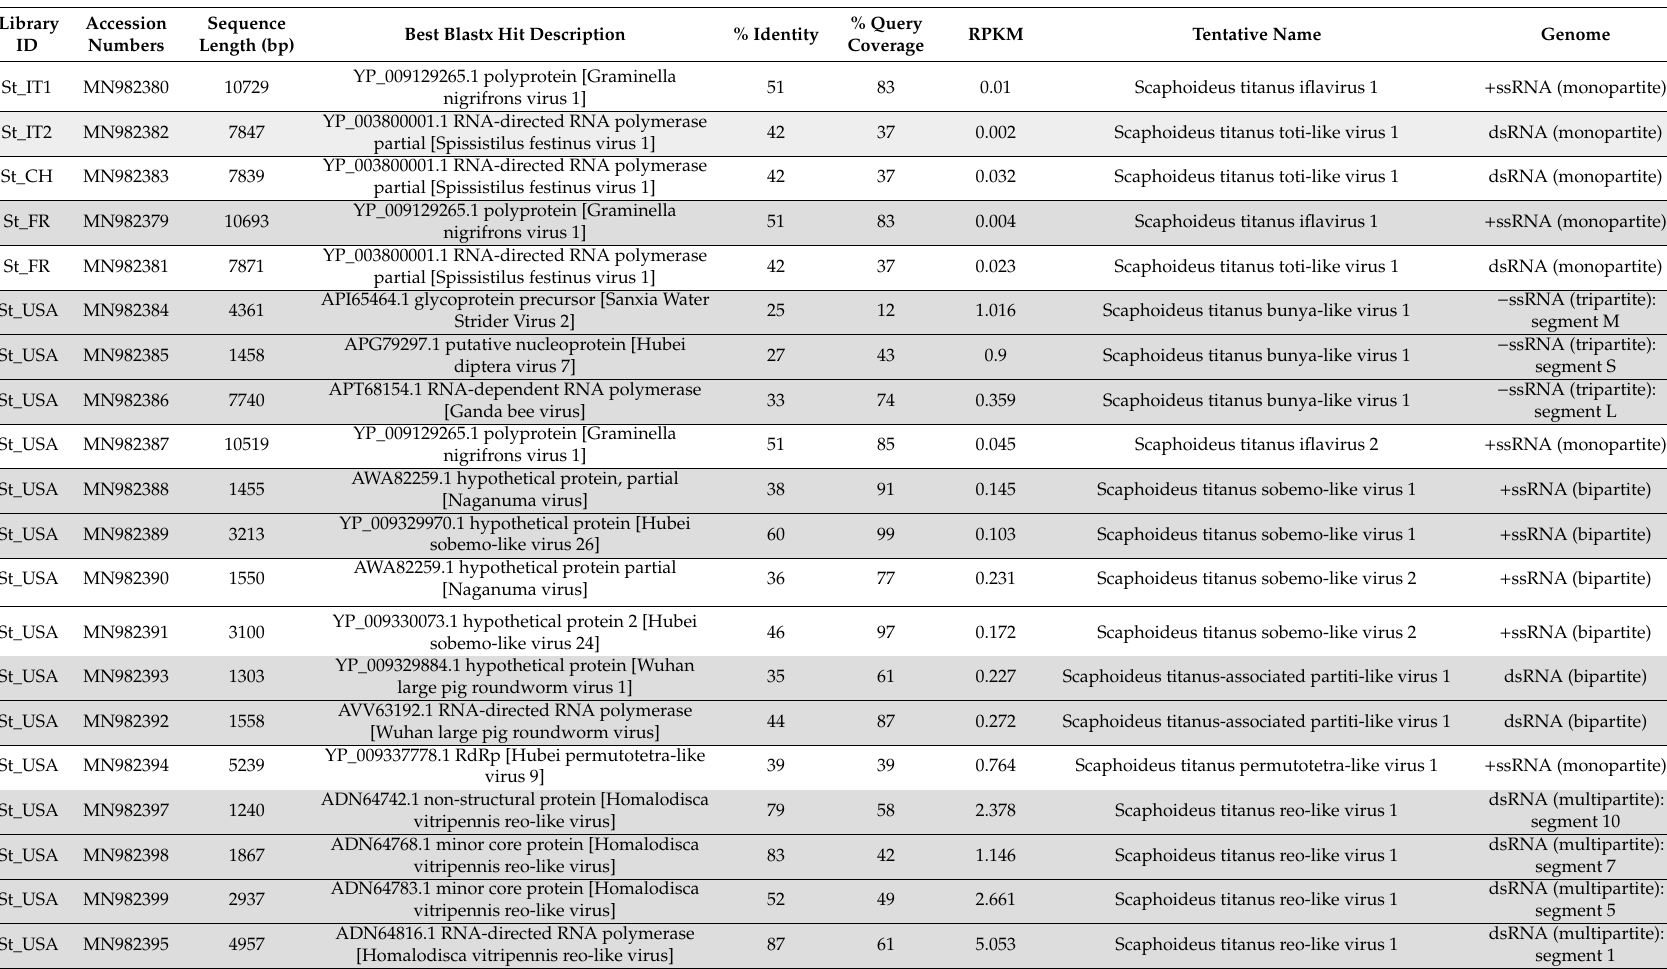
Table 2. List of the sequences assigned to putative insect-infecting viruses found in each RNA-seq library. Column 9 reports the kind ( + ssRNA, -ssRNA and dsRNA) and structure (monopartite / multipartite) of the viral genomes identified in this work. The identification of segments in some multipartite genomes is also